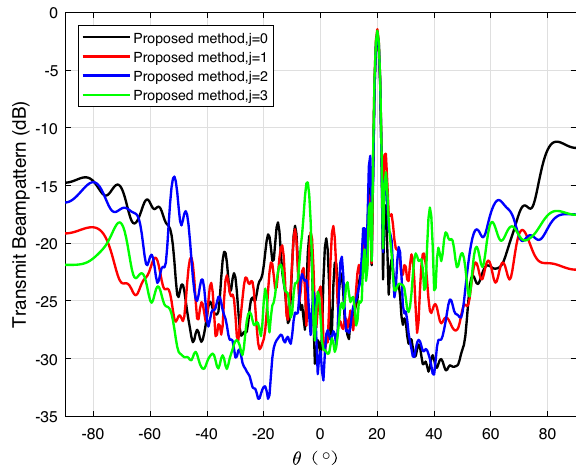
Fig. 7 The beampattern behaviors for different number of